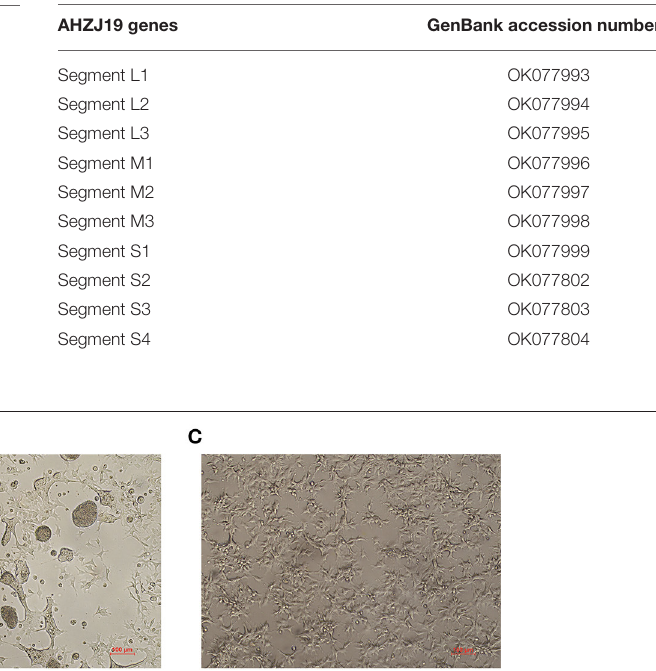
TABLE 3 | The GenBank accession numbers for the obtained sequences of